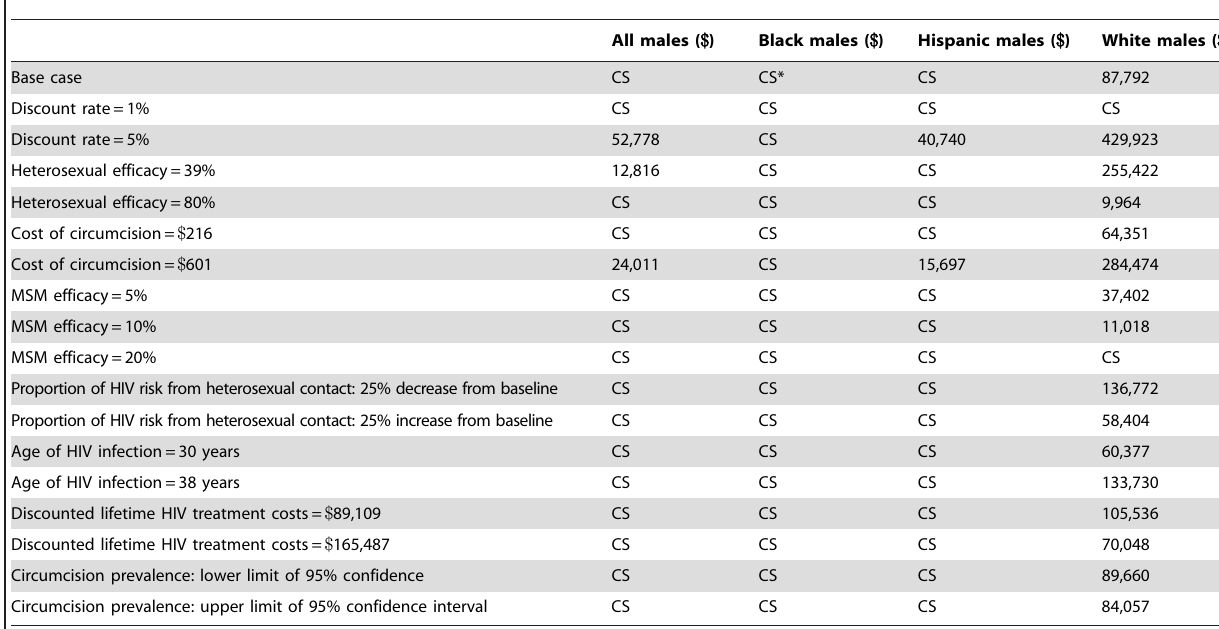
Table 4. One-way sensitivity analyses: incremental cost of newborn circumcision per quality-adjusted life-year saved for all U.S. males and by race/ethnicity.